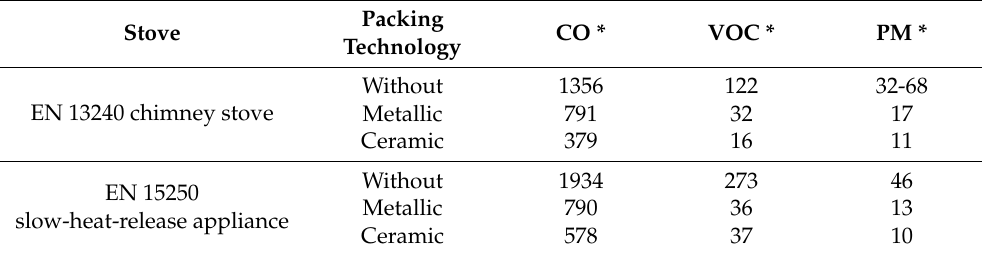
Figure 13. Comparison of flue gas temperature measurements in a chimney stove (EN 13240) with and without an integrated packing module [60] (translated into English). Reprint with permission from M. Aleysa, P. Leistner, Verbesserung des Verbrennungs- und Emissionsverhaltens in biomassebetriebenen Einzel-raumfeuerungsanlagen durch den Einsatz spezieller Einbauten; Copyright 2016, Fraunhofer Institute for Building Physics (IBP). Table 3. Results of experimental lab tests with and without integrated packing technology in two different types of firewood room-heating appliances (best-practice heating operation mode using beech firewood)